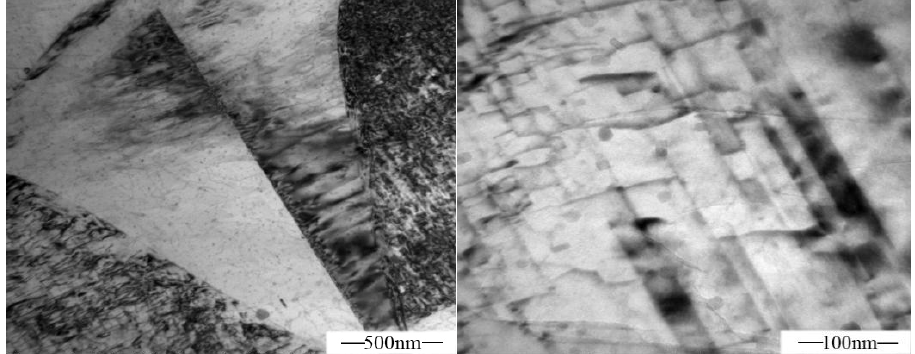
Figure 10. TEM results of twin crystal area at 3 mg/cm 2 .